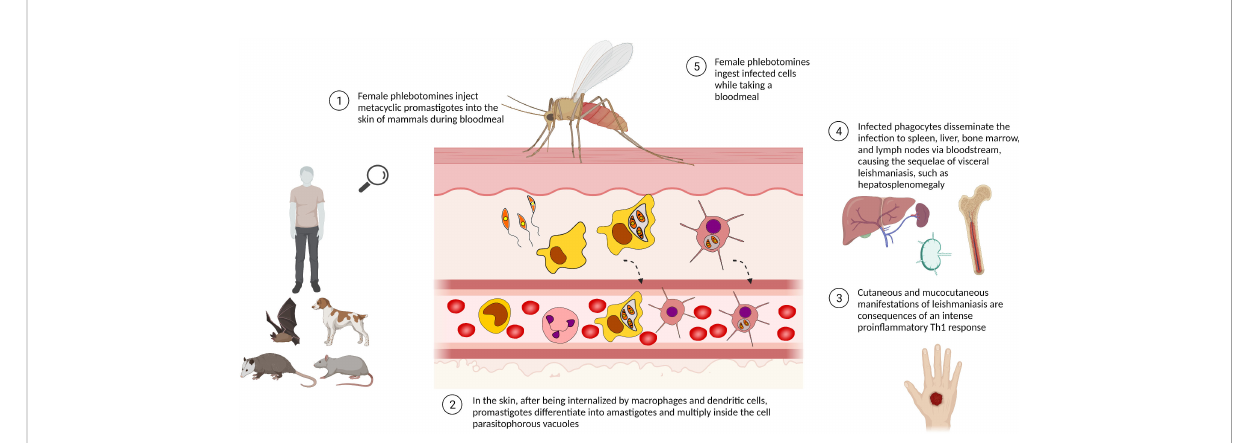
FIGURE 1 Life cycle of Leishmania spp. The life cycle of Leishmania spp. alternates between phlebotomine sand fl y and mammalian hosts, e.g. sylvatic/ domestic animals and human beings. Leishmania promastigotes are phagocytosed by mononuclear phagocytic cells, differentiating into amastigotes and multiplying by binary fi ssion as an obligate intracellular parasite. The presence of a high number of intracellular parasites promotes the host cell disruption, releasing parasites able to infect other cells/tissues. Infected phagocytes can also reach lymphoid organs, disseminating the disease. Phlebotomine sand fl ies ingest Leishmania-infected cells while taking a bloodmeal and transmit leishmaniasis by biting man or other mammals. Created with